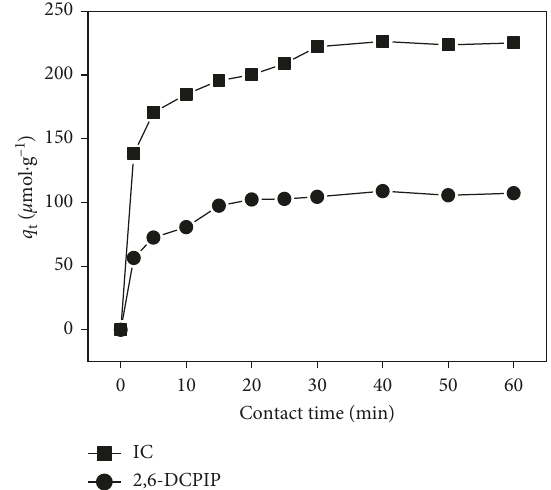
Figure 7: Effect of biosorbents dose on the IC and 2,6-DCPIP adsorption.